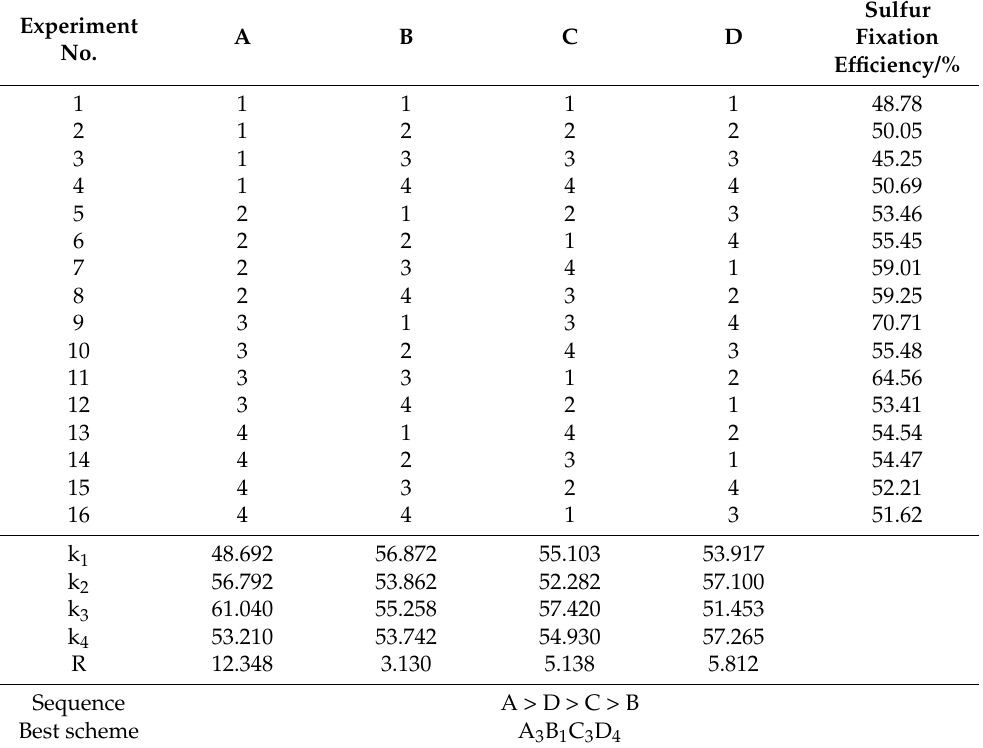
Table 4. Orthogonal experiments plan and experiment results analysis.